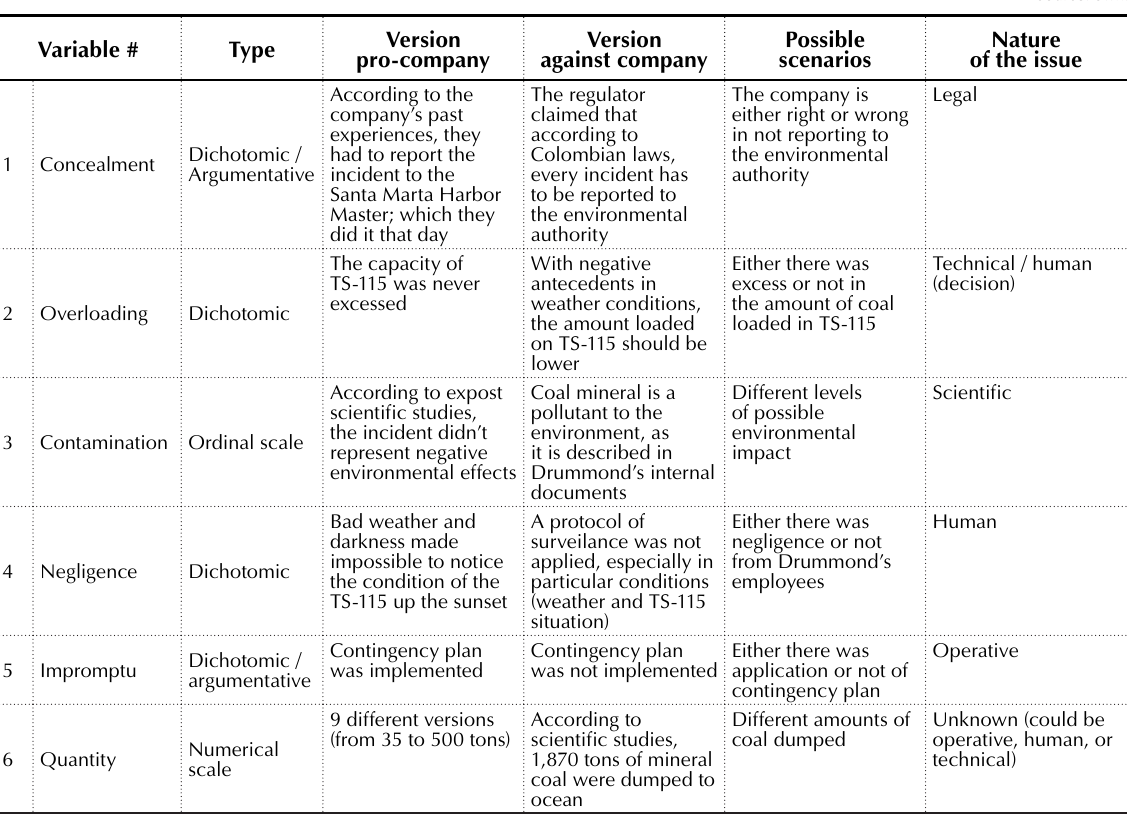
Table 1. Potential variables to